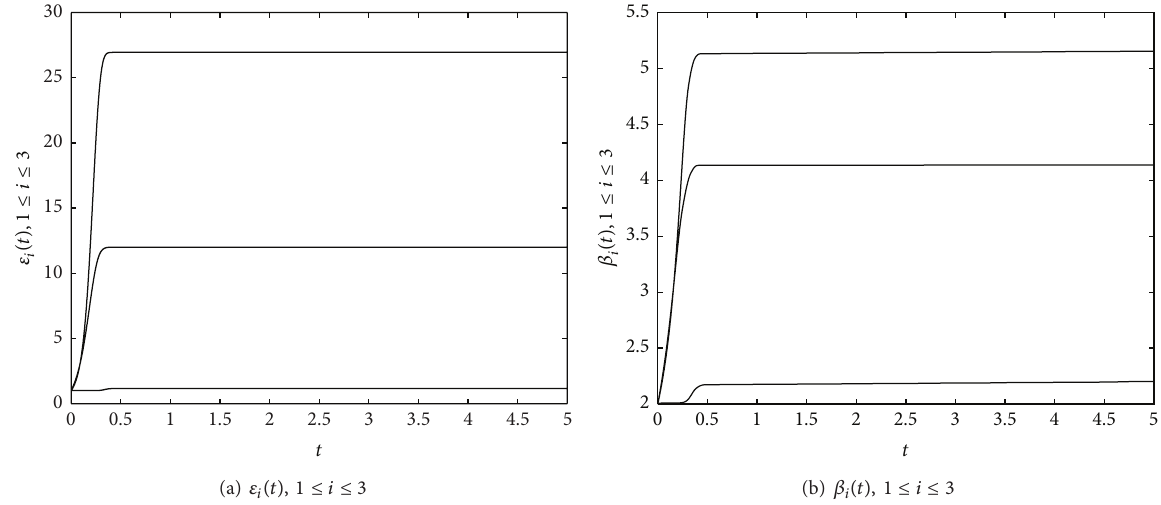
Figure 4: Feedback gain parameters 𝜀 𝑖 (𝑡) (a) and 𝛽 𝑖 (𝑡) (b) (1 ≤ 𝑖 ≤ 3) of (30) with adaptive controller (9).